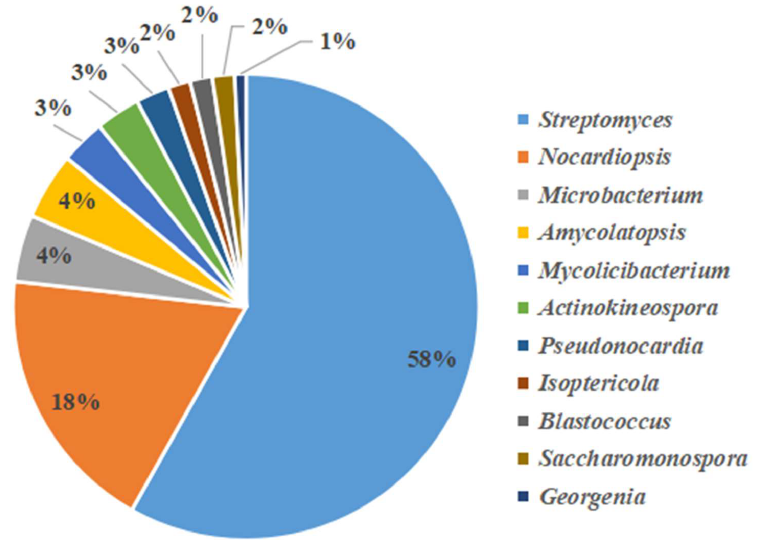
Figure 4. Pie chart showing the percentage relative abundance of the genera in actinobacteria from samples analyzed by the culturable method. Table 4 . Classification of actinobacteria from Flaming Mountain region.